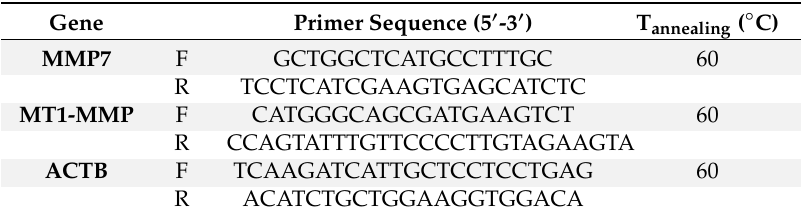
Table 1. Primer sequences used for quantitative